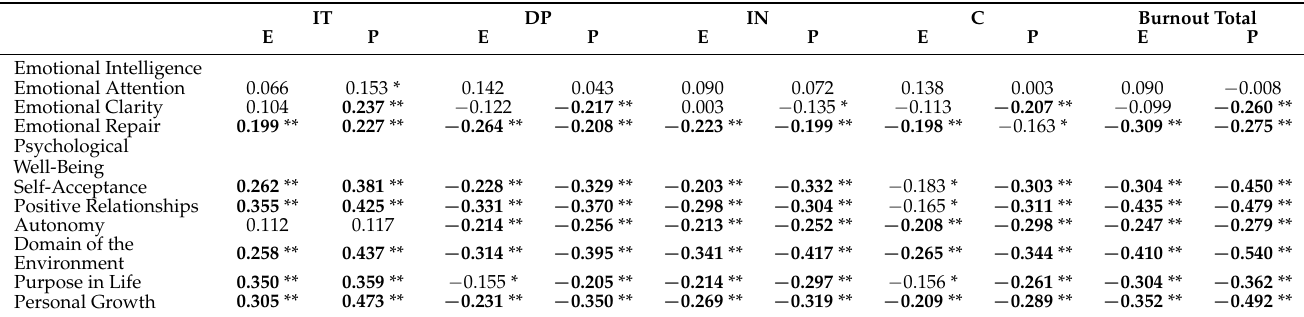
Table 4. Significant differences in the relationship between emotional intelligence and psychological well-being and burnout in active and in-training teachers.